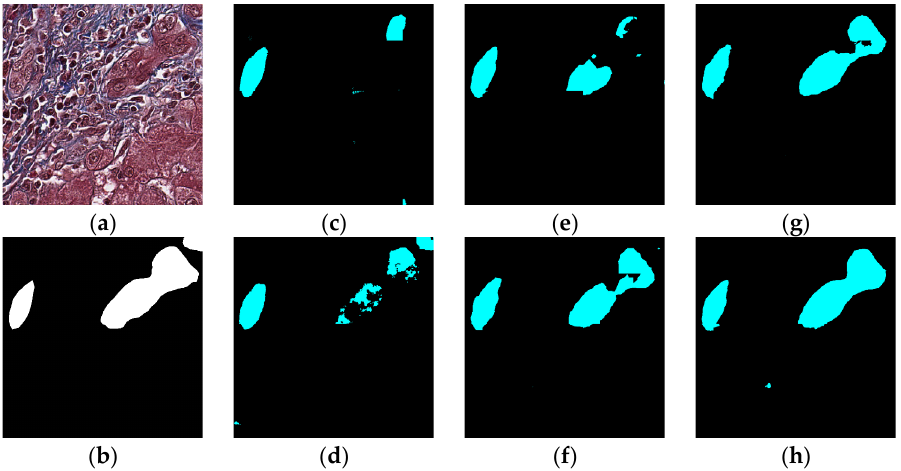
Figure 12. Segmentation results for the case in which the bile duct is between the hepatocyte area and the classic bile ducts: original ( a ), GT ( b ), FCN ( c ), SegNet ( d ), U ‐ Net ( e ), Deeplabv3 ( f ), Deeplabv3 ‐ plus ( g ), and the proposed network ( h ).